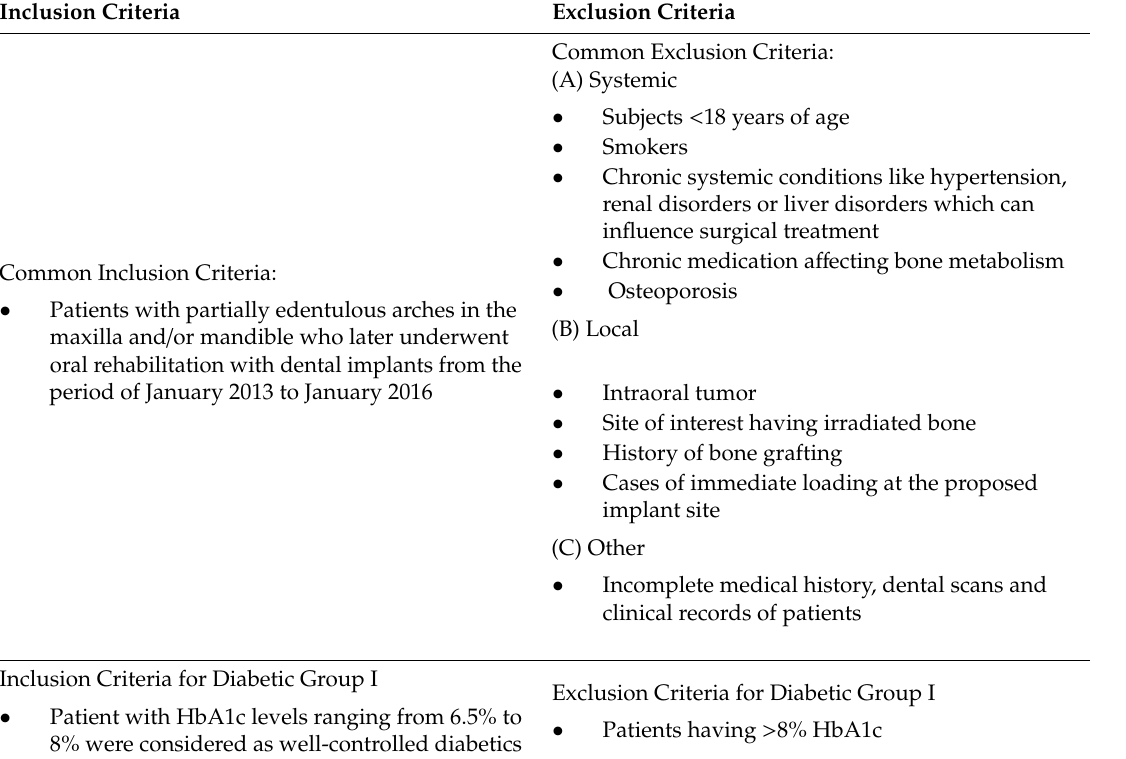
Table 1. Inclusion and exclusion criteria for the